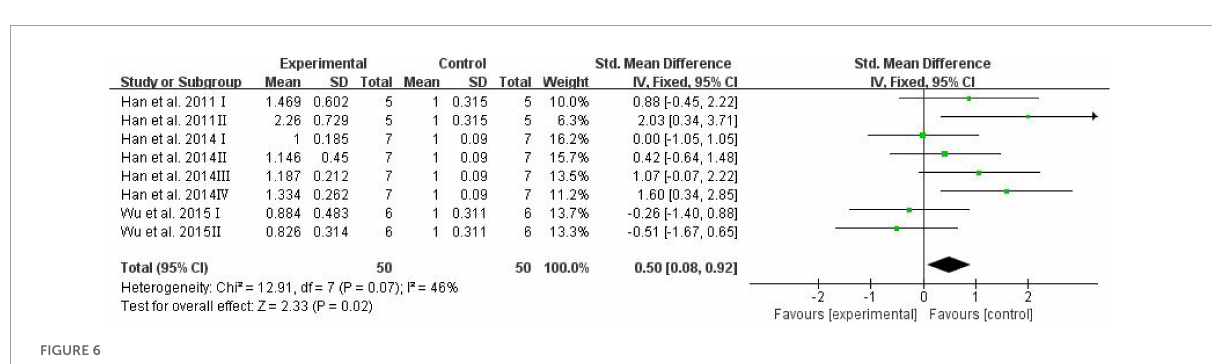
FIGURE6 Forest plot of the serum